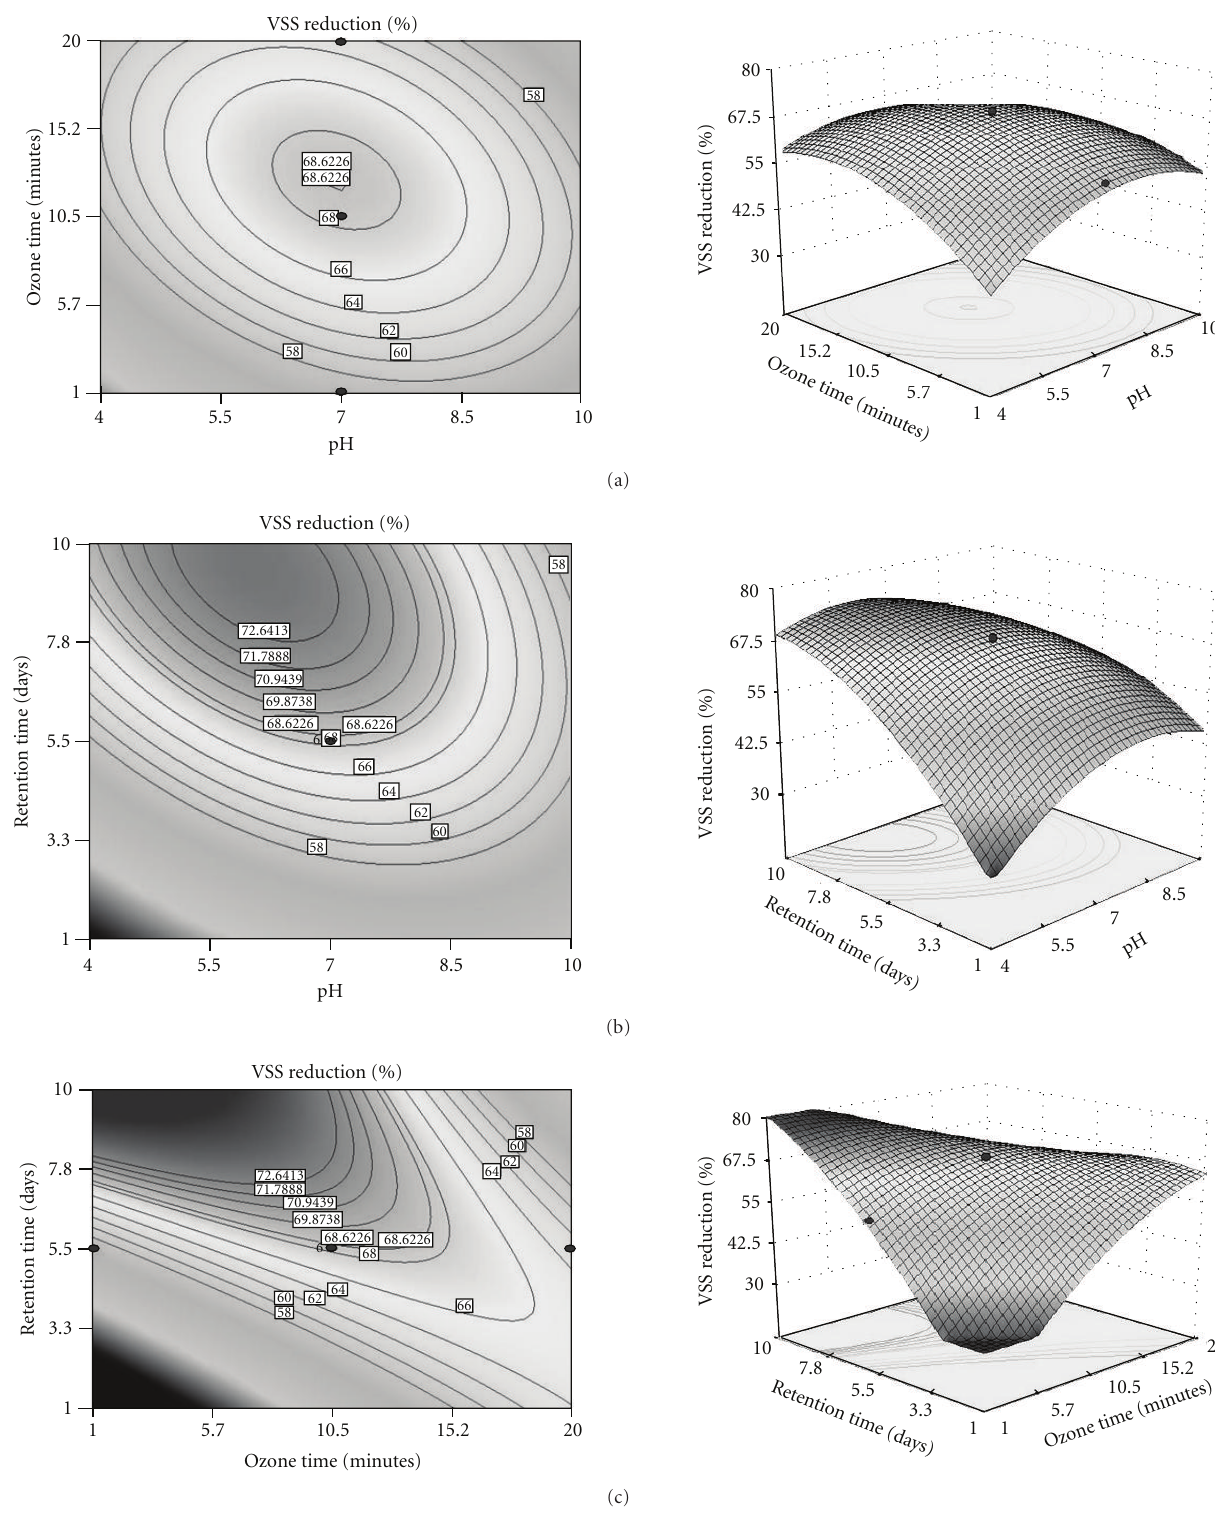
Figure 1: Contour and three-dimensional surface plot of VSS reduction. (a) E ff ect of pH and ozone time at fixed retention time (5.5 days). (b) E ff ect of pH and retention time at fixed ozone time (10.5 minutes). (c) E ff ect of ozone time and retention time at fixed pH